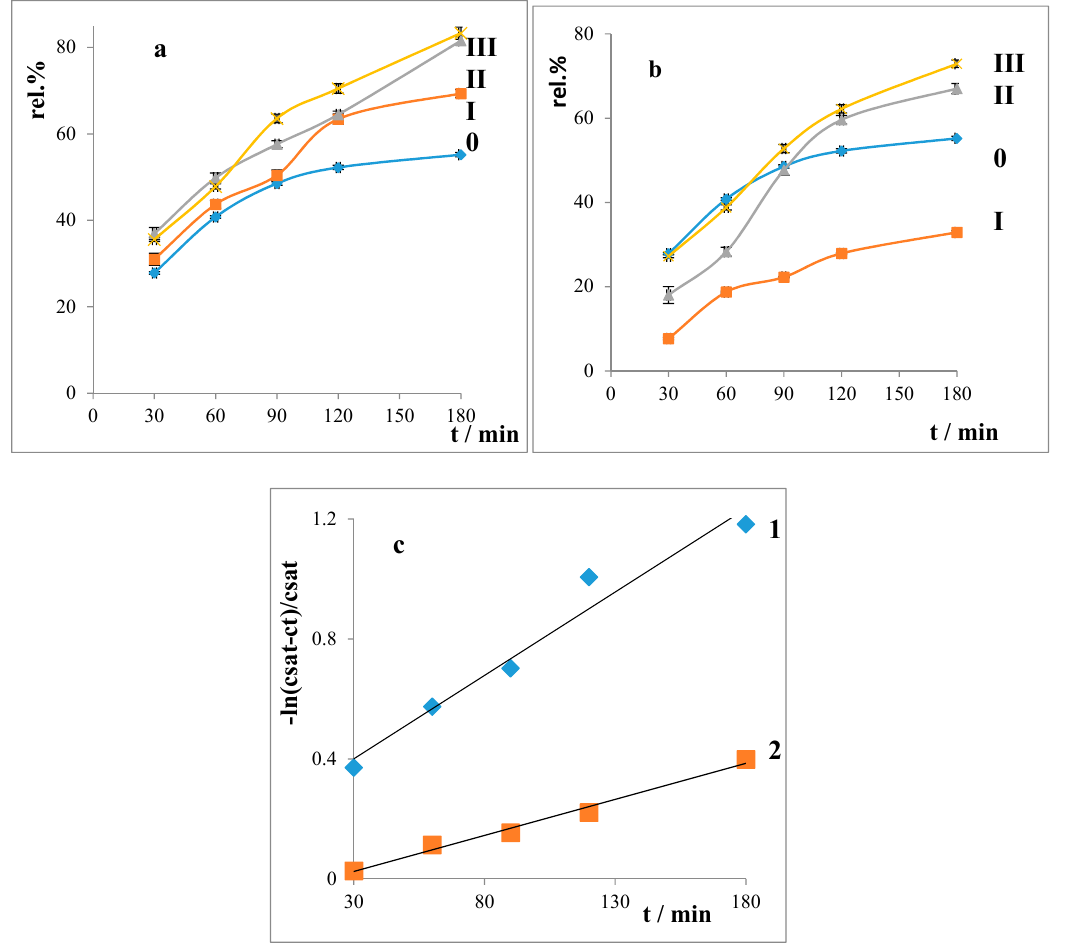
Figure 6. Liberation of CHX ( a ) below the CMC; and ( b ) above the CMC of surfactants, numbers: curve release of CHX from hydrogel without surfactants, I : C12, II : C14 and III : C16; ( c ) curves for the determination of the release rate constants of CHX from hydrogels with surfactant C12 1 -below CMC and 2 -above CMC pri t = 30 °C.